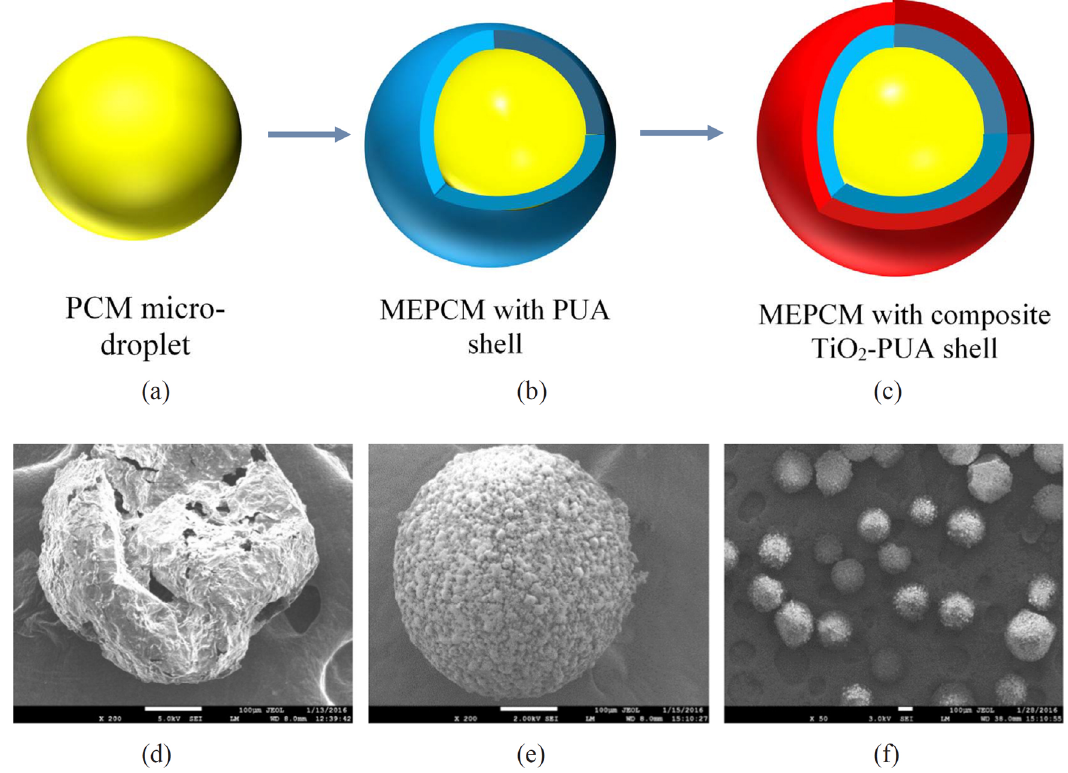
Figure 9: Schematic drawing of ( a ) PCM micro - droplet, ( b ) microencapsulated PCMs ( MEPCMs ) with PUA shell, and ( c ) MEPCMs with TiO 2 – PUA shell. Micrographs of ( d ) individual MEPCM with PUA shell and ( e ) individual MEPCM with TiO 2 – PUA shell. ( f ) Fabricated free - fl owing MEPCMs [ 78 ]